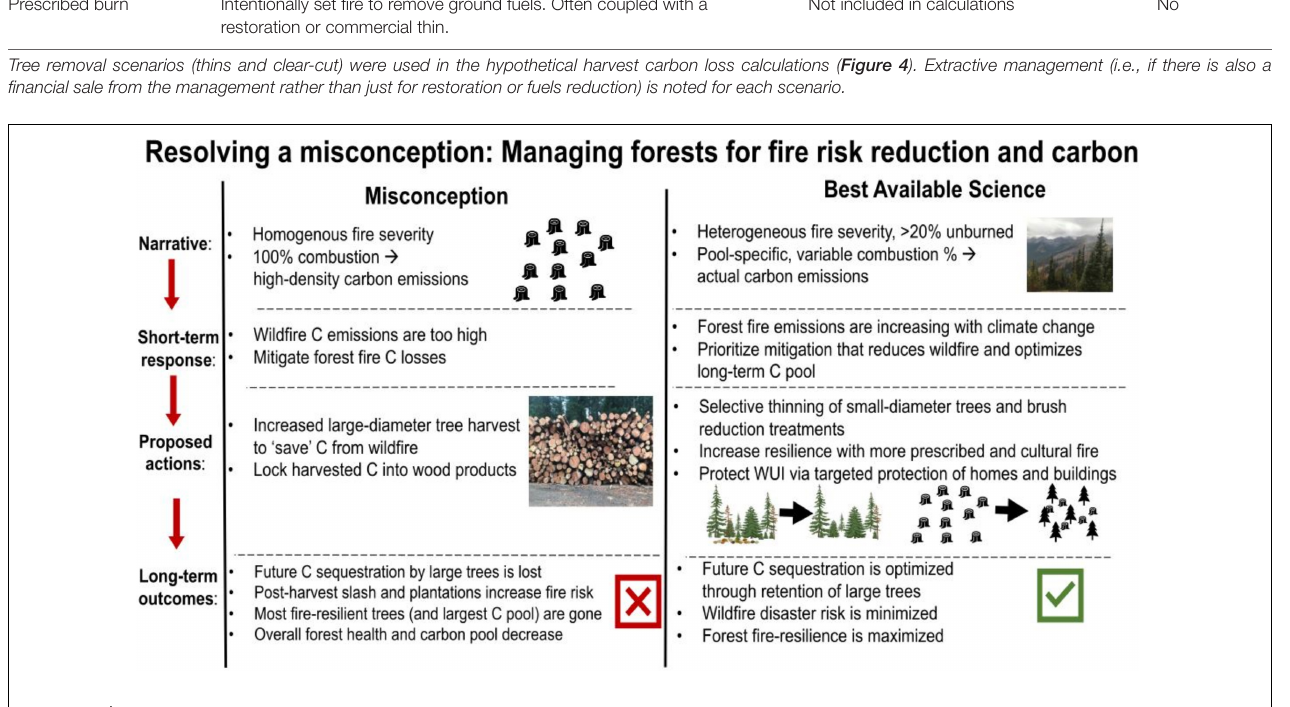
FIGURE 1 | Conceptual figure describing the misconception about extractive forest management (Column 1) and how it can lead to unintended and unwanted consequences with forest resilience and the forest carbon sink. Column 2 describes how we can correct that misconception and develop policies that enhance forest resilience and the forest carbon sink. TABLE 2 | Examples of recent public opinions surrounding the logging-forest-carbon misconceptions and how they lead to policy that increases